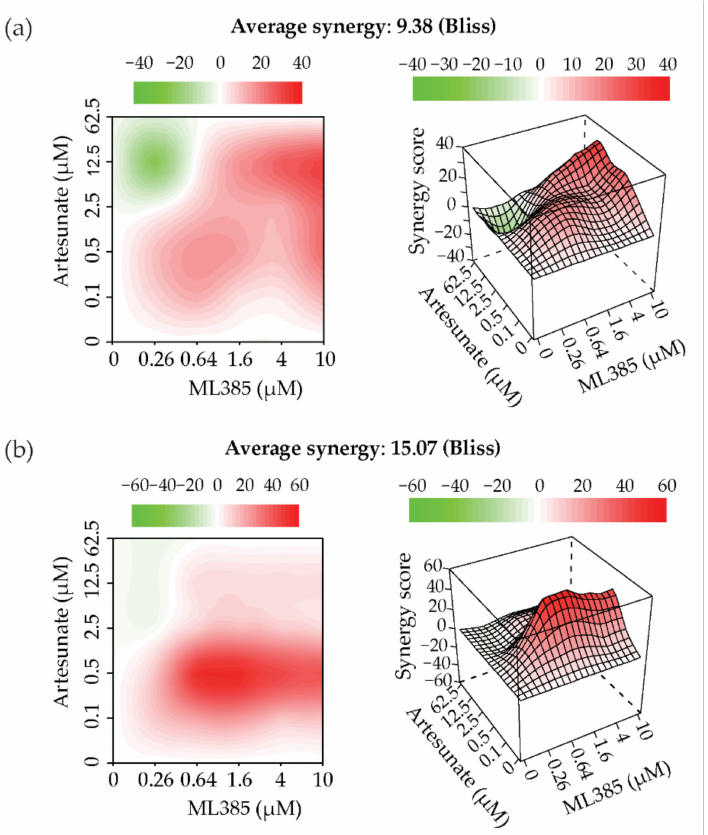
Figure 6. Artesunate is synergistic with ML385 (Nrf2 inhibitor). ( a ) Graphic representation of the Bliss independence model of synergy scoring as calculated by using a 6 × 6 dose–response matrix in A549 ( a ) and H1299 ( b ) cells. Red color indicates synergy, while green indicates antagonism between the drug combinations